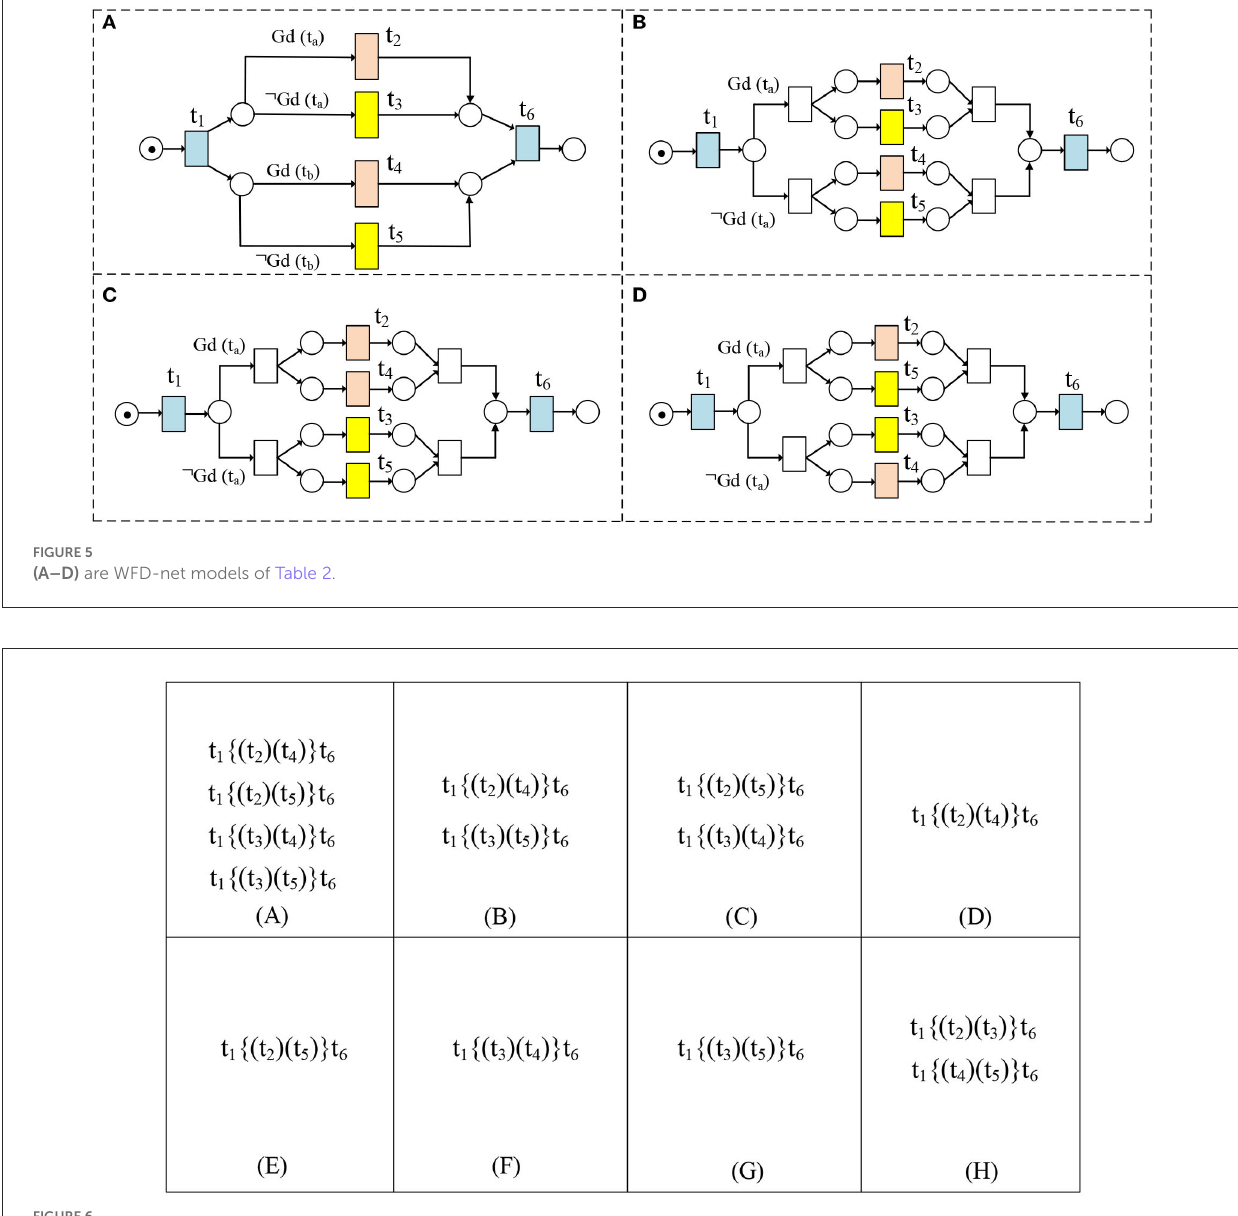
FIGURE6 DTC ( Weidlich et al., 2011) method: (A) shows the traces of Figure 5A, (H) shows the traces of Figure 5B, (B) shows the traces of Figure 5C, and (C) shows the traces of Figure 5D. Our method: (A–G) shows the traces of Figure 5A, (H) shows the traces of Figure 5B, (B) shows the traces of Figure 5C, and (C) shows the traces of Figure